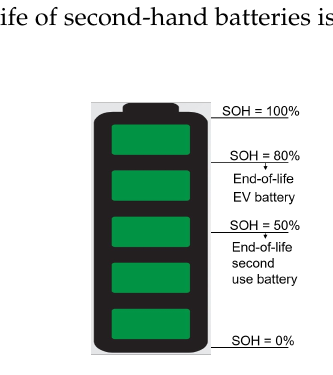
Figure 3. Battery end-of-life